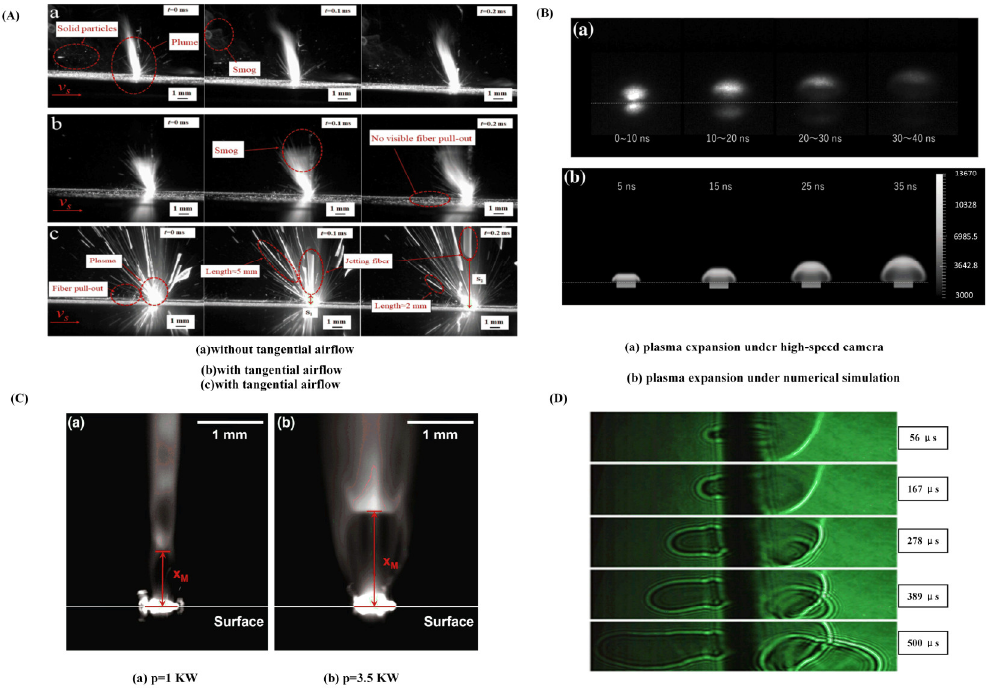
Figure 7. Plasma expansion of laser-processed CFRP captured by high-speed camera : ( A ) plasma in various air ambiances [36]; ( B ) burning waves at various pulse counts [47]; ( C ) diagram of a plasma plume in smoke [46]; ( D ) the phenomena of mushroom-like eruptions [45].